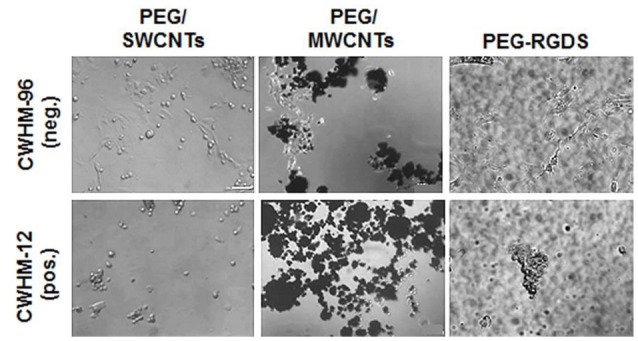
Phase contrast images of PC12 cells in serum-free medium upon exposure to CWHM-12 (pos.) and CWHM-96 (neg.) peptidomimetics. Scale bar is 100 μm.